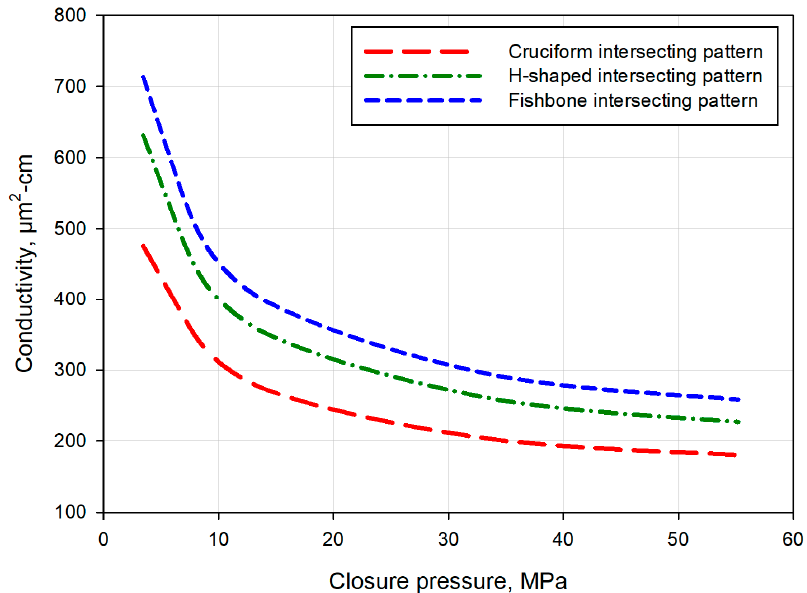
Figure 14. Comparison evolution of fractures with different intersecting patterns but identical proppants (40/70 mesh) and proppant concentrations (5 kg/m 2 ).